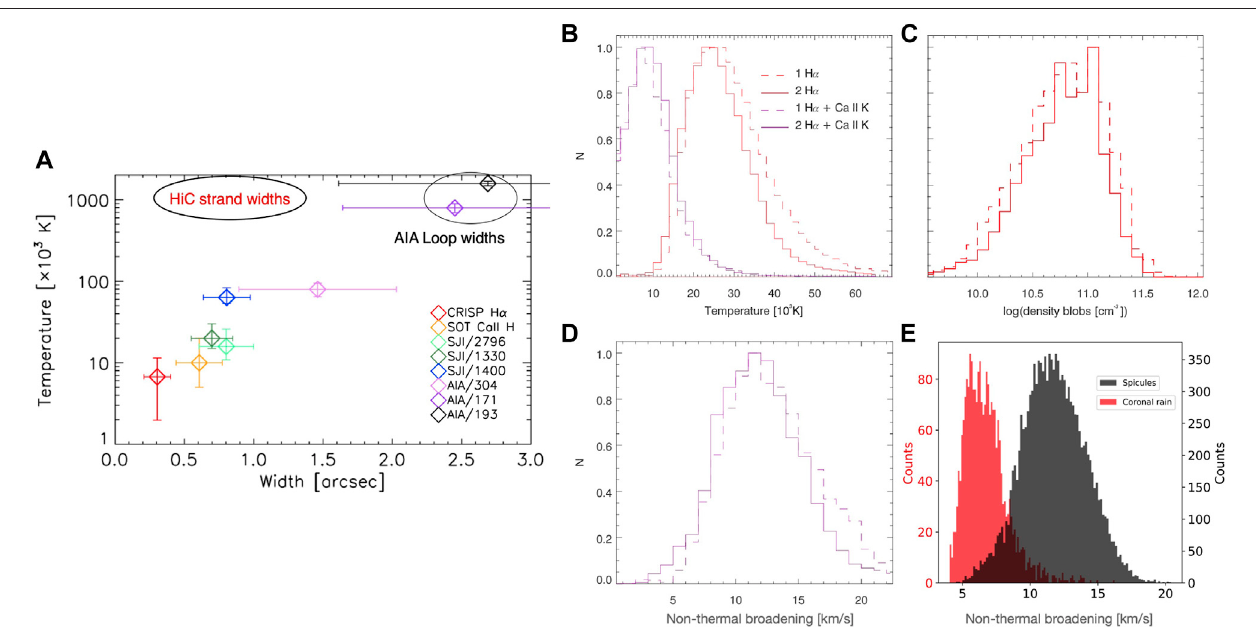
FIGURE 10 | Statistics of rain widths and thermodynamic properties. (A) measured widths of coronal rain clumps with respect to the measured temperature, as observed in different lines from various instruments (each with different colour, see legend in the panel) by Antolin et al. (2015) (adapted from Figure 17, © AAS. Reproduced with permission). The AIA loop widths hosting the clumps are shown. In addition, we add the region corresponding to the Hi-C strands (Williams et al., 2020).Right,4-panel:Temperatures[ (B) ,in unitsof10 3 K],Densities[ (C) ,cm − 3 ] and Non-thermal broadening [ (D) , km/s]ofrainclumps observedin Fromentet al. (2020) with the SST /CRISP (in H α ) and CHROMIS (in Ca II K) instruments (from Figures 12 and 15 of that paper, reproduced with permission © ESO). Non-thermal broadening [ (E) ,km/s] observed inKriginsky et al. (2021) with SST /CRISP (in H α )and CHROMIS(in Ca II8542) (fromFigure 7that paper, reproduced withpermission © ESO). In panel (E) a comparison with measurements for spicules seen in the same FOV is